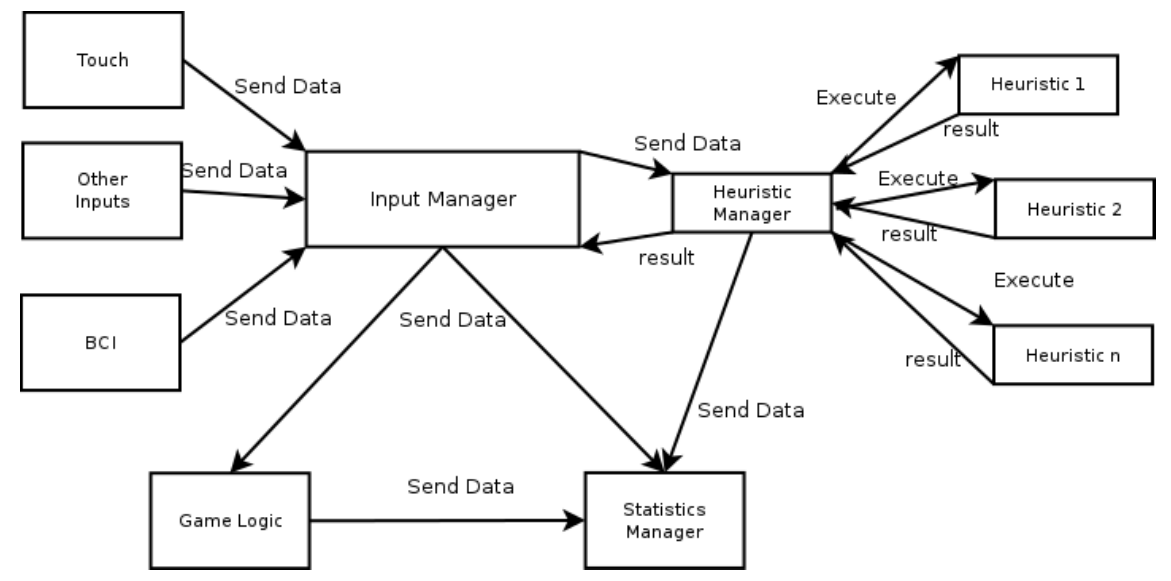
Figure 3: The Input Manager